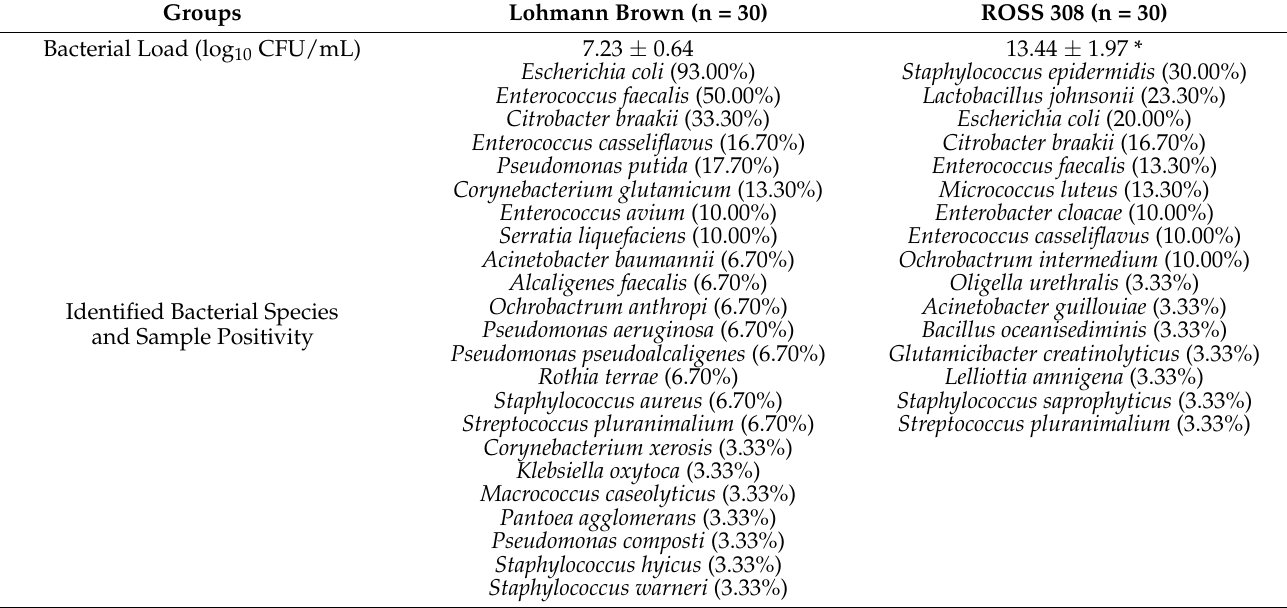
Table 1. Bacterial profiles of semen samples collected from Lohmann Brown and ROSS 308 roosters.